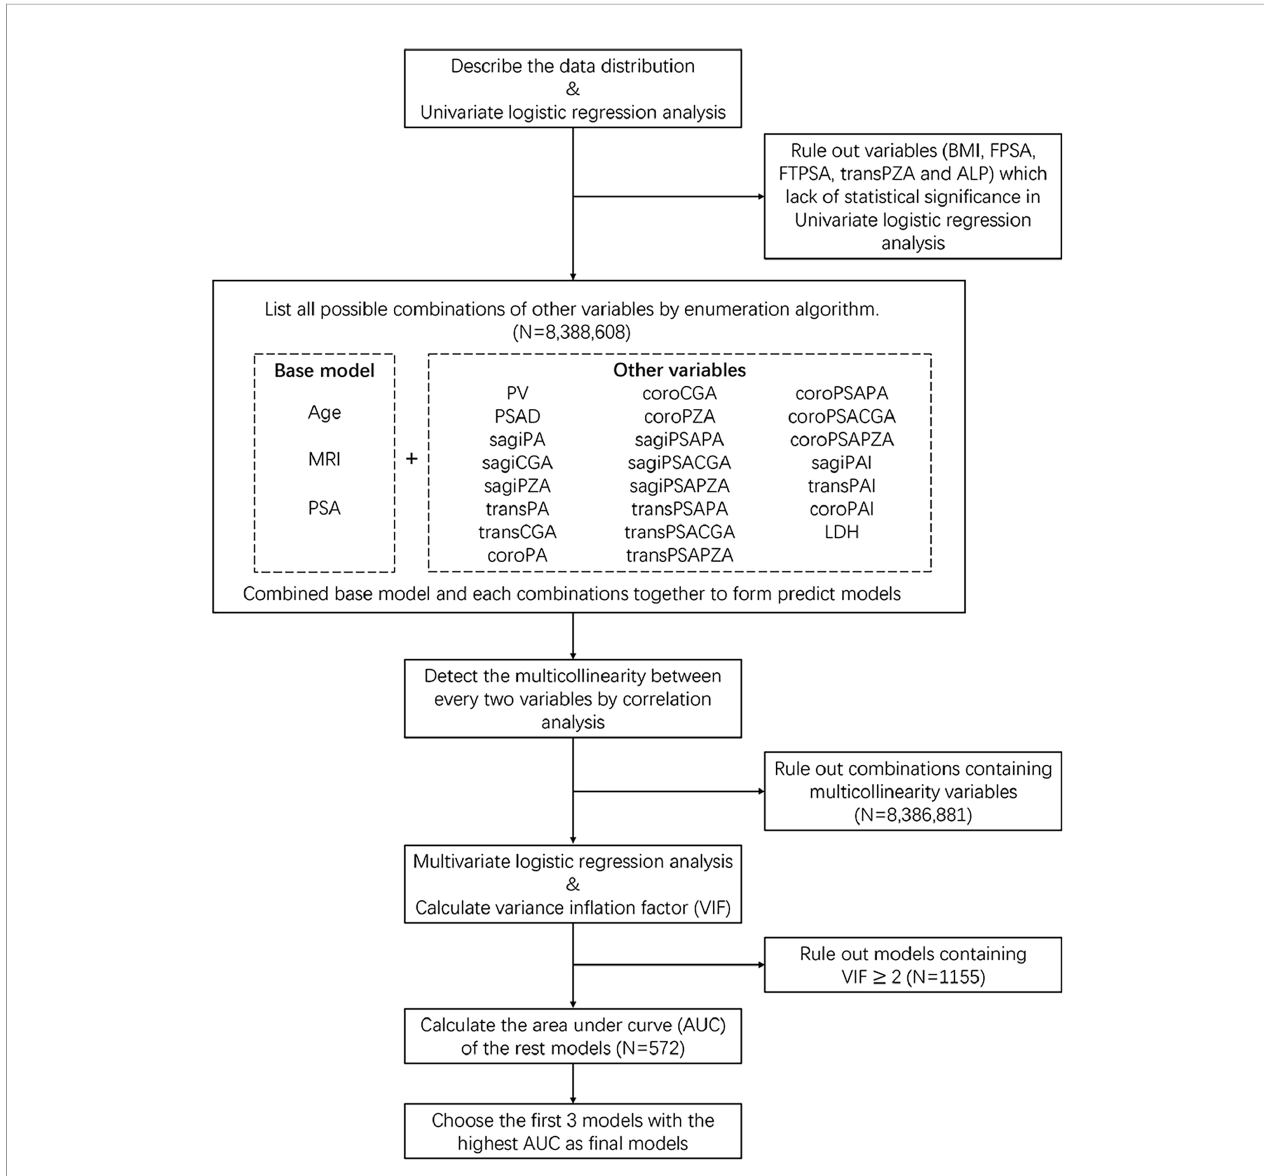
FIGURE 2 | Flow chart of statistical